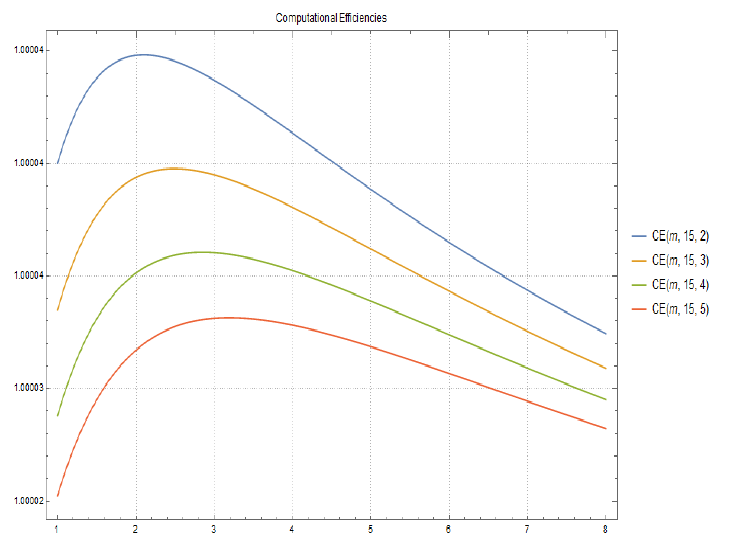
Figure 3. Computational Efficiencies for q = 15 and different values of p and m .